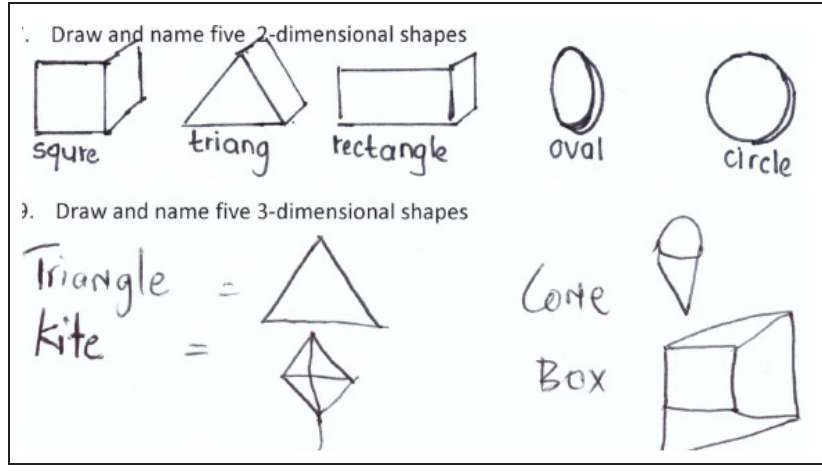
Figure 5: Erroneous drawings of 3-D shapes